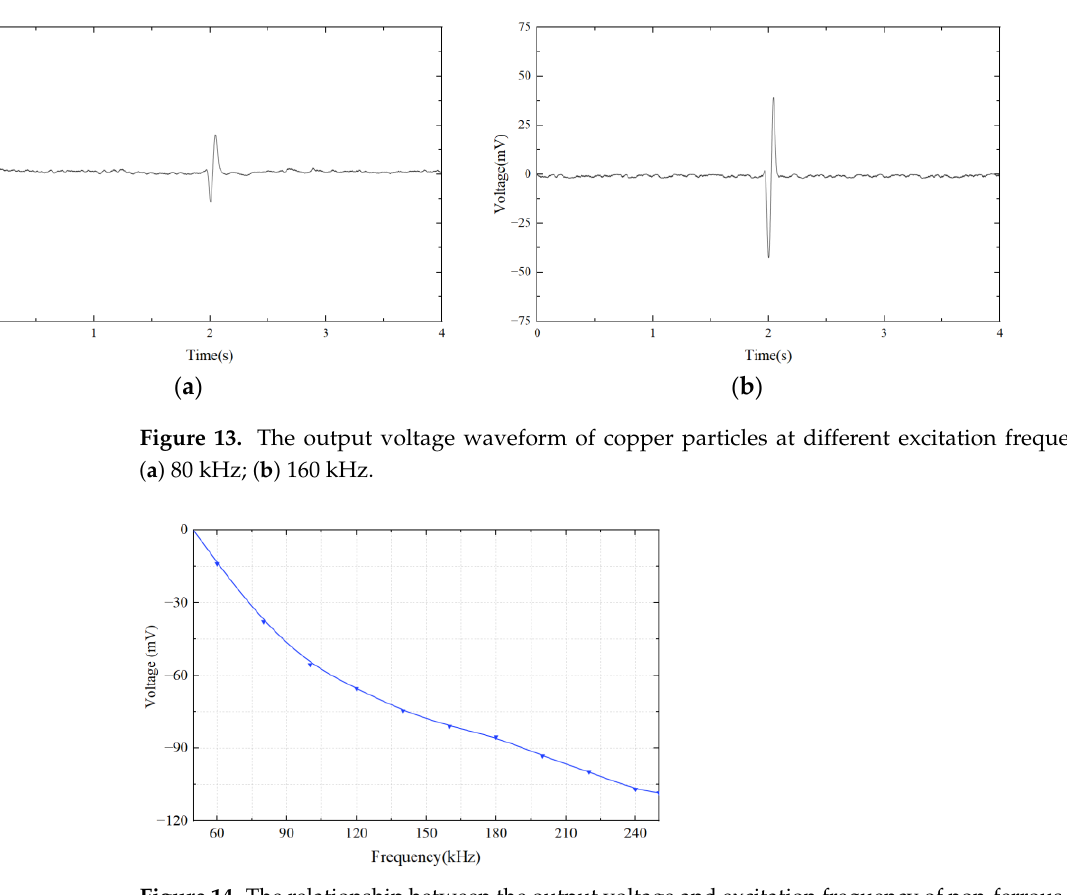
Figure 12. The microphotograph of 800 µm copper particles.